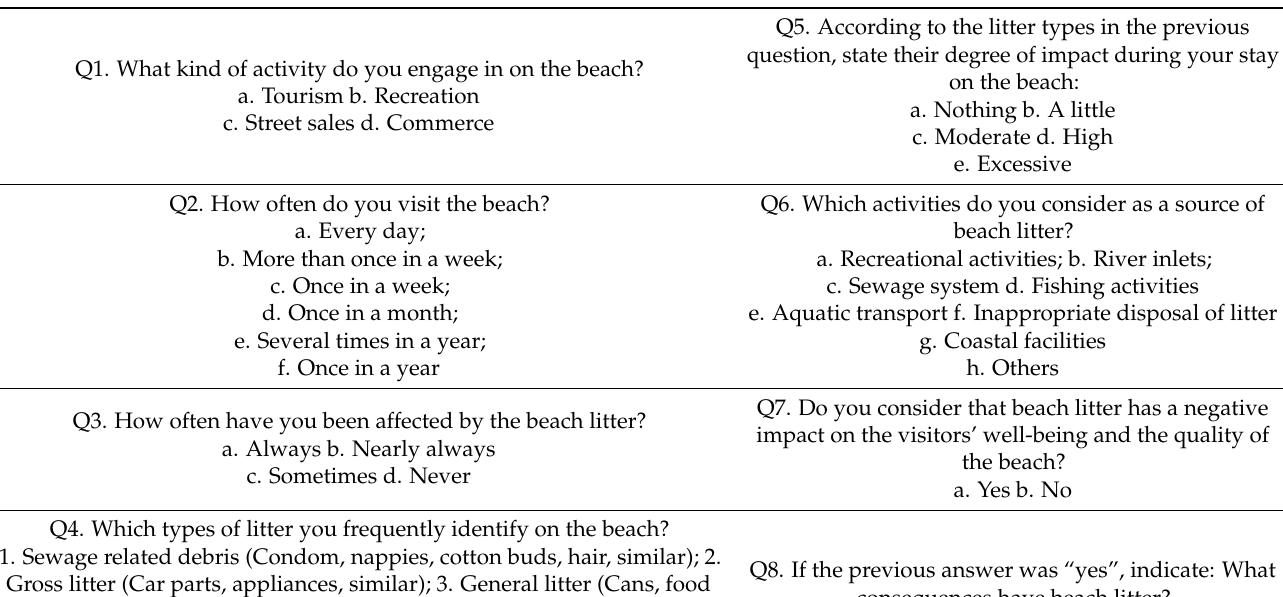
Table 1. User survey applied on beaches of the Northern Caribbean coast of Colombia and sociodemographic data of